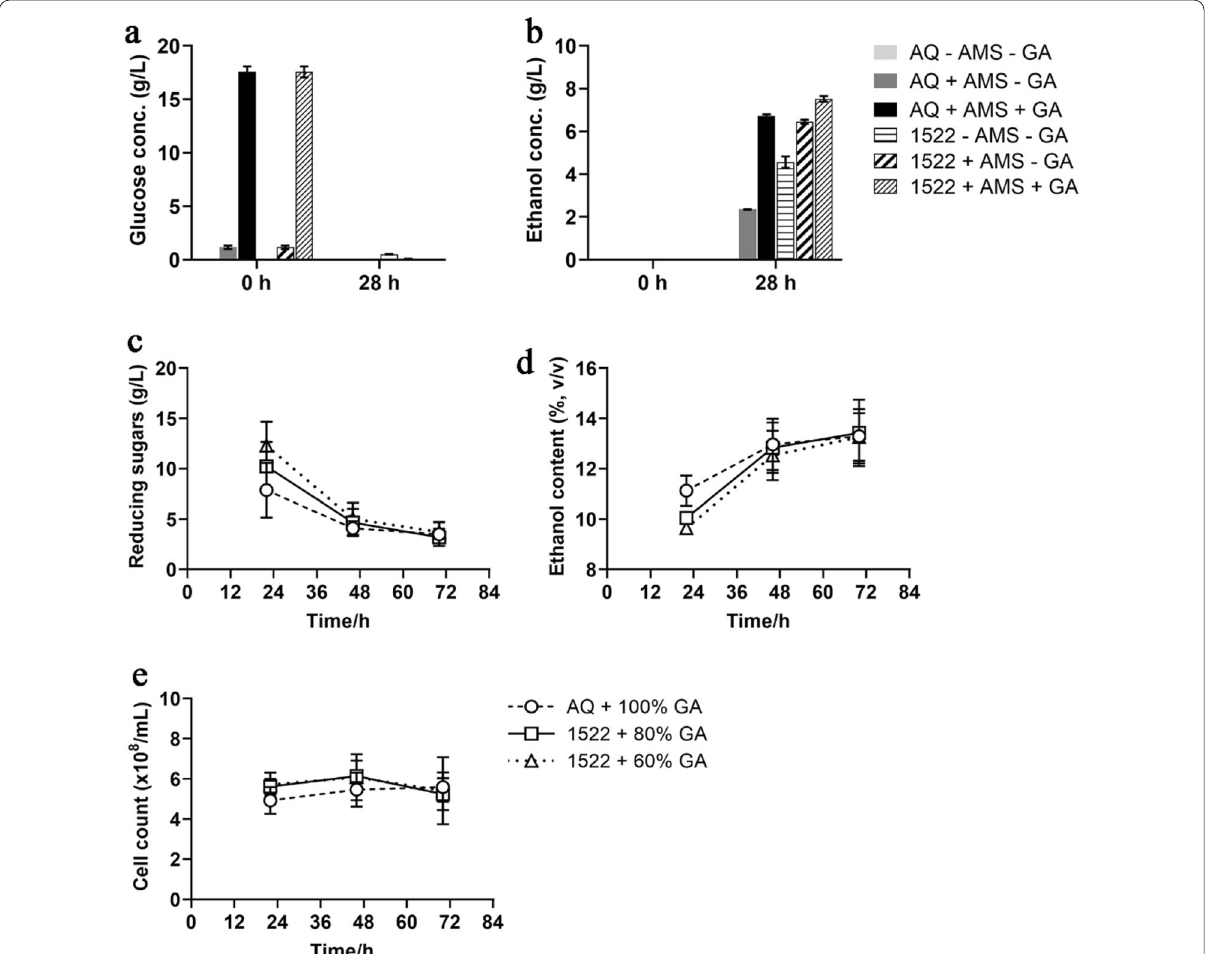
Fig. 3 The fermentation performance of glucoamylase expressing yeast strains using cassava starch in small and large-scale fermentations. Glucose ( a ) and ethanol concentration ( b ) produced by the CIBTS1522 or the parental strain supplemented with or without α-amylase and glucoamylase under test tube conditions. c – e represent the reducing sugars ( c ), ethanol content ( d ), and cell count ( e ) under 50 L-scale fermentation condition by the parental and CIBTS1522 strains supplemented with different dosages of glucoamylase. GA glucoamylase, AMS